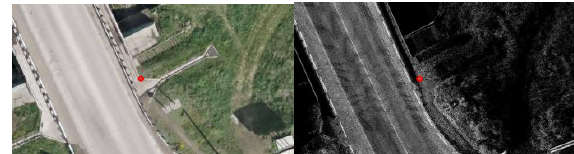
Figure 4. Distribution of points on the orthophoto plan for horizontal positional accuracy estimation (Left: orthophoto plan, Right: MLS